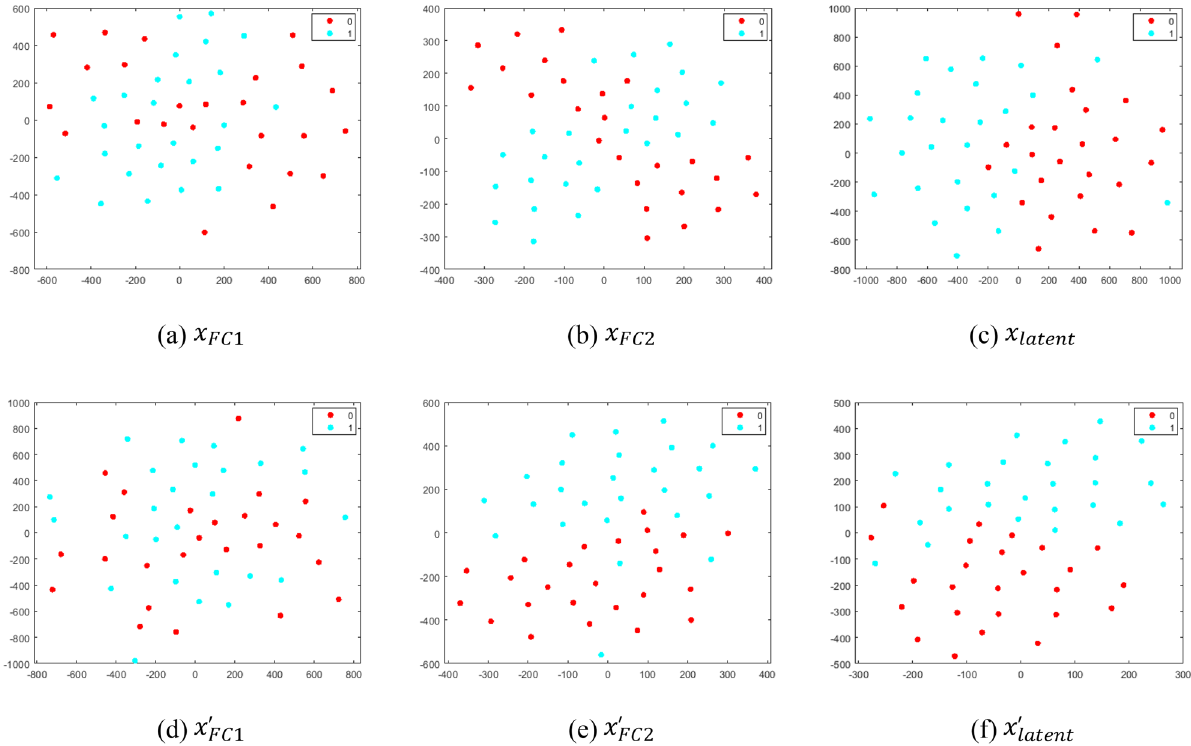
Figure 11. The scatter plot for latent features mapped to R 2 using the t-SNE technique illustrating Stage 1 for classification of mpMRI scans into MGMT+ (“1”) and MGMT− (“0”) classes for the original dataset: ( a ) FC1 features x FC 1 , ( b ) FC2 features x FC 2 , and ( c ) latent features x latent . The results depicting visual classification with the rejection algorithm are: ( d ) x ′ FC 1 ( e ) x ′ FC 2 , and ( f ) x ′ latent